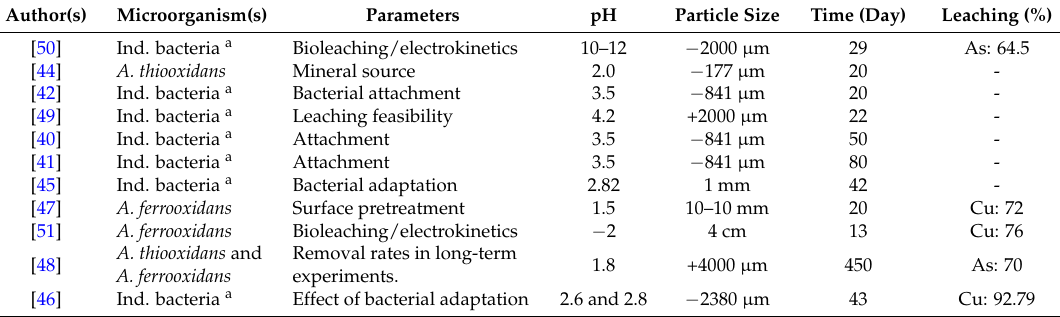
Table 2. Bioleaching research of mine tailings according to the parameters studied and recoveries achieved as well as microorganisms used in the studies. The articles appear in chronological order.